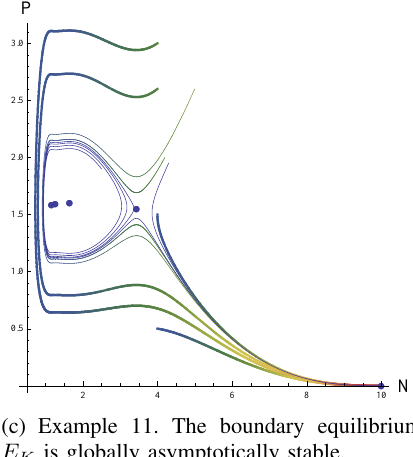
(c) Example 11. The boundary equilibrium E K is globally asymptotically stable. Fig. 16. Dynamics of system (4) in the case of four unstable internal equilibrium